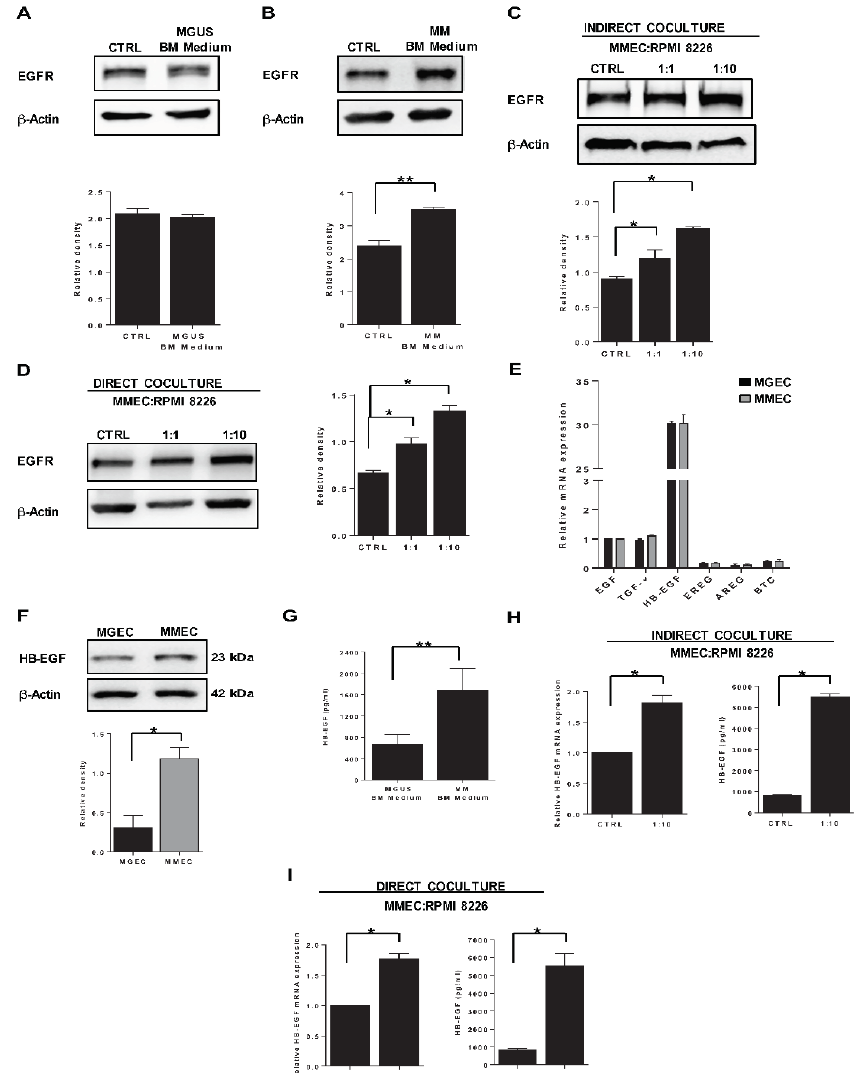
Figure 2. Bone marrow microenvironment influences EGFR and HB-EGF expression in MMEC. Western blots of EGFR and ≥β -actin in MMEC and results of densitometric analyses of EGFR normalized to β -actin. ( A , B ) MMEC were maintained for 24 h in normal culture medium (CTRL) or culture medium conditioned by bone marrow mononuclear cells (BMMC) from ( A ) MGUS patients (MGUS BM medium) or ( B ) MM patients (MM BM medium). ( C , D ) MMEC were grown for 24 h, alone (CTRL) or in coculture with RPMI 8226 cells at 1:1 and 1:10 cell ratios, separated ( C ) or not ( D ) by Transwell inserts. All charts report data from six patients. Each sample was tested in triplicate with similar results. ( E ) Basal relative mRNA levels of six EGFR ligands in MGEC and MMEC, determined by real-time PCR. Values were normalized to that of EGF. Samples from six MGUS and six MM patients were tested in triplicate. ( F ) Western blots of HB-EGF and β -actin in MGEC and MMEC, and results of densitometry analysis of HB-EGF, normalized to β -actin. Samples from six MGUS and six MM patients were tested in triplicate. ( G ) ELISA determination of HB-EGF in conditioned culture medium from BMMC of 12 MGUS and 12 MM patients. ( H , I ) Relative HB-EGF mRNA levels ( left ) and ELISA determinations of soluble HB-EGF in conditioned medium ( right ) of MMEC cultured for 24 h, alone (CTRL) or in coculture with RPMI 8226 cells, indirectly ( H ) or directly ( I ). Samples from six patients were tested in triplicate. Values are expressed as mean and SD, * p < 0.05 and ** p < 0.01, Mann–Whitney U